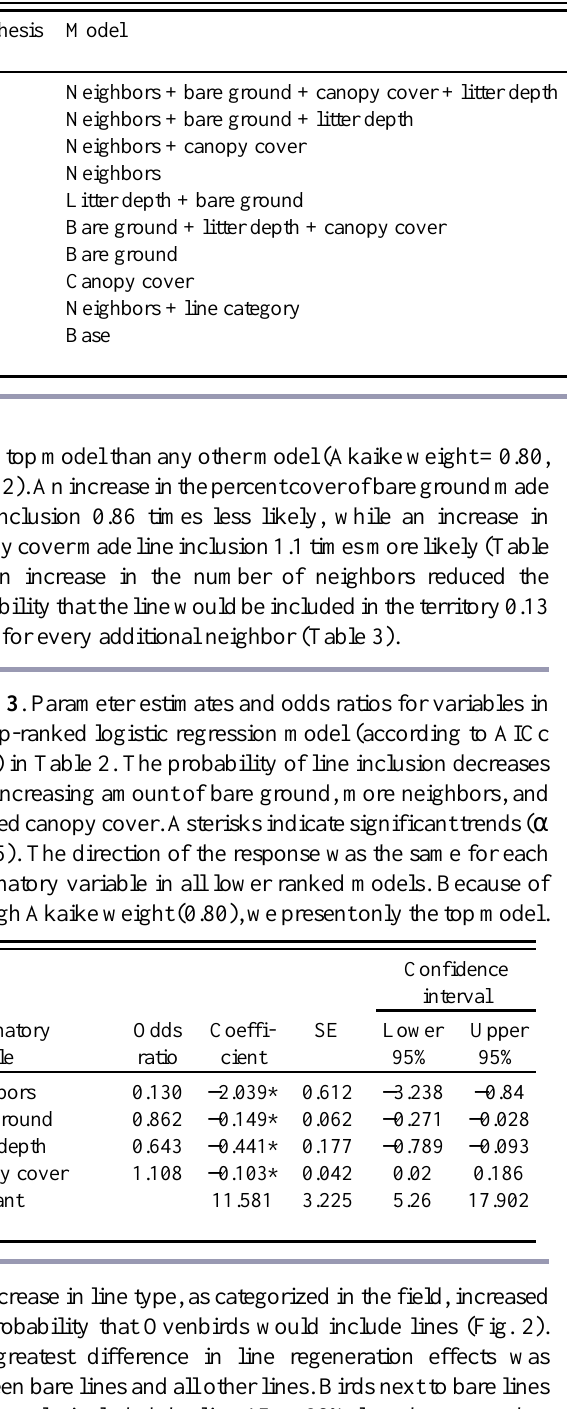
Table 2 . Ranked logistic regression models predicting probability of line inclusion ranked by AICc score. The full sample size of 52 birds was used in all models. Models are identified by hypothesis: N = neighbors hypothesis; F = food hypothesis; P = predation hypothesis. Both hypotheses and models are presented because there are multiple models for each hypothesis as well as combined models. The evidence ratio (ER) shows the support for the top model relative to all other models, while the Akaike weights ( w ) indicate the probability that a model ranks higher than the lower ranked models.